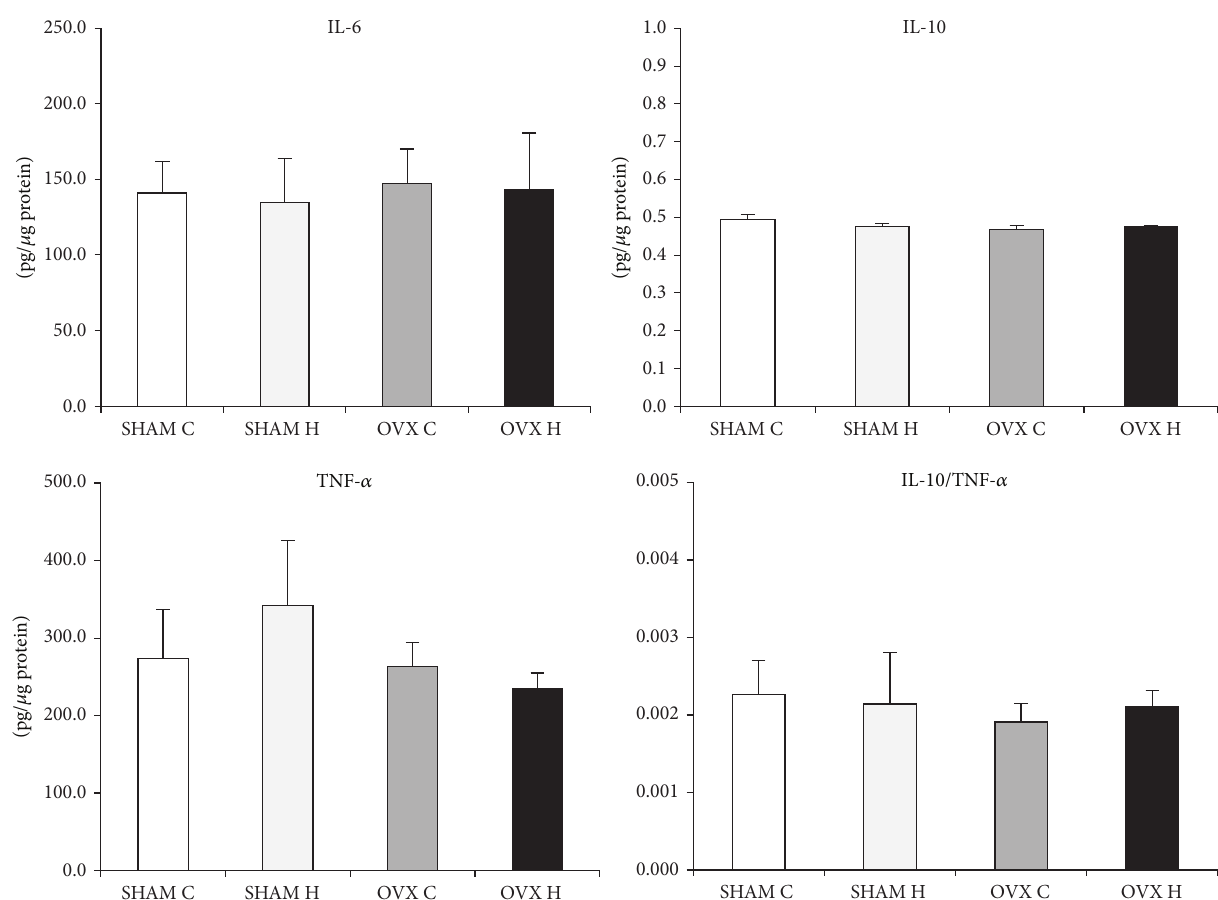
Figure 3: Gastrocnemius muscle cytokines content of studied rats groups: (SHAM C) sham group treated with control diet; (SHAM H) sham group treated with hyperlipidic diet; (OVX C) ovariectomized group treated with control diet; (OVX H) ovariectomized group treated with hyperlipidic